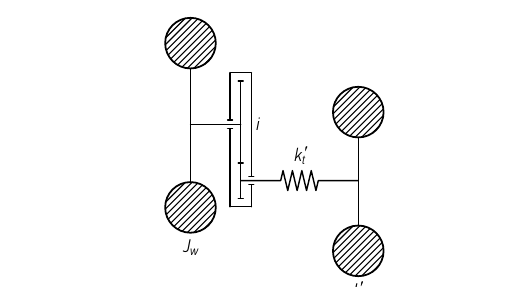
J w J r (cid:31) Fig. 5. The simplified torsional system of wheelset drive